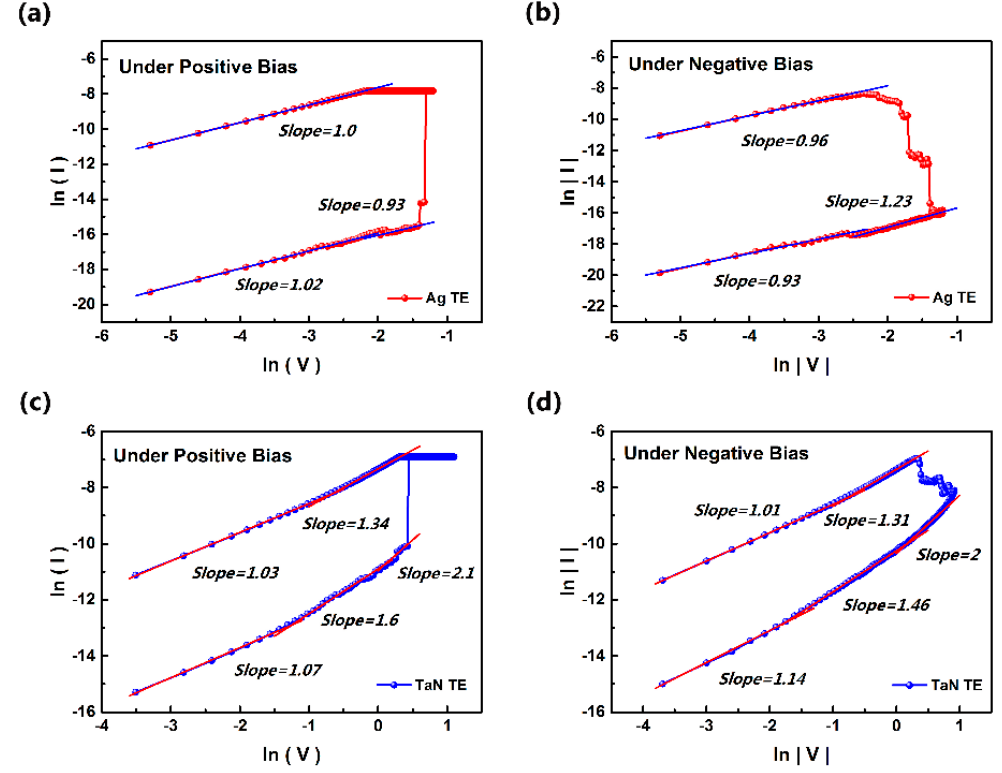
Figure 2. The current fitting of the Ag/HfO 2 /Pt devices at ( a ) positive and ( b ) negative electric field; the current fitting of the TaN/HfO 2 /Pt devices at ( c ) positive and ( d ) negative electric field.